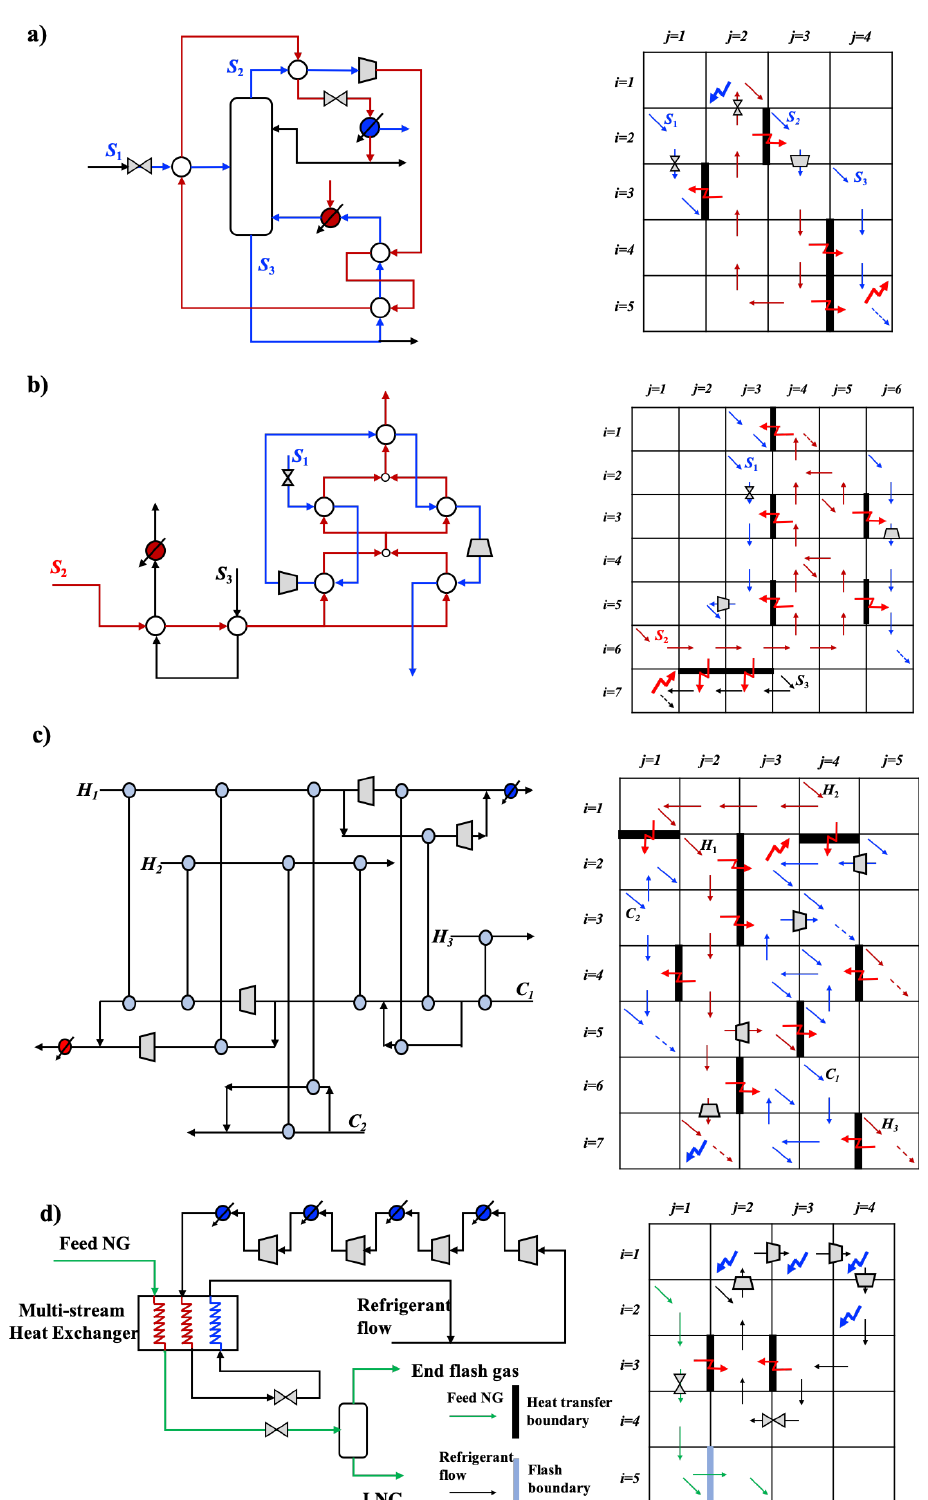
Figure 3. Various flowsheets and networks representations for work and heat integration in WHENS: ( a ) Work and heat exchange network for a separation system. ( b ) Work and heat exchange network for liquefied energy chain. ( c ) Work and heat exchange network with three hot streams and two cold streams. ( d ) Work and heat exchange network for single mixed refrigerant (SMR)